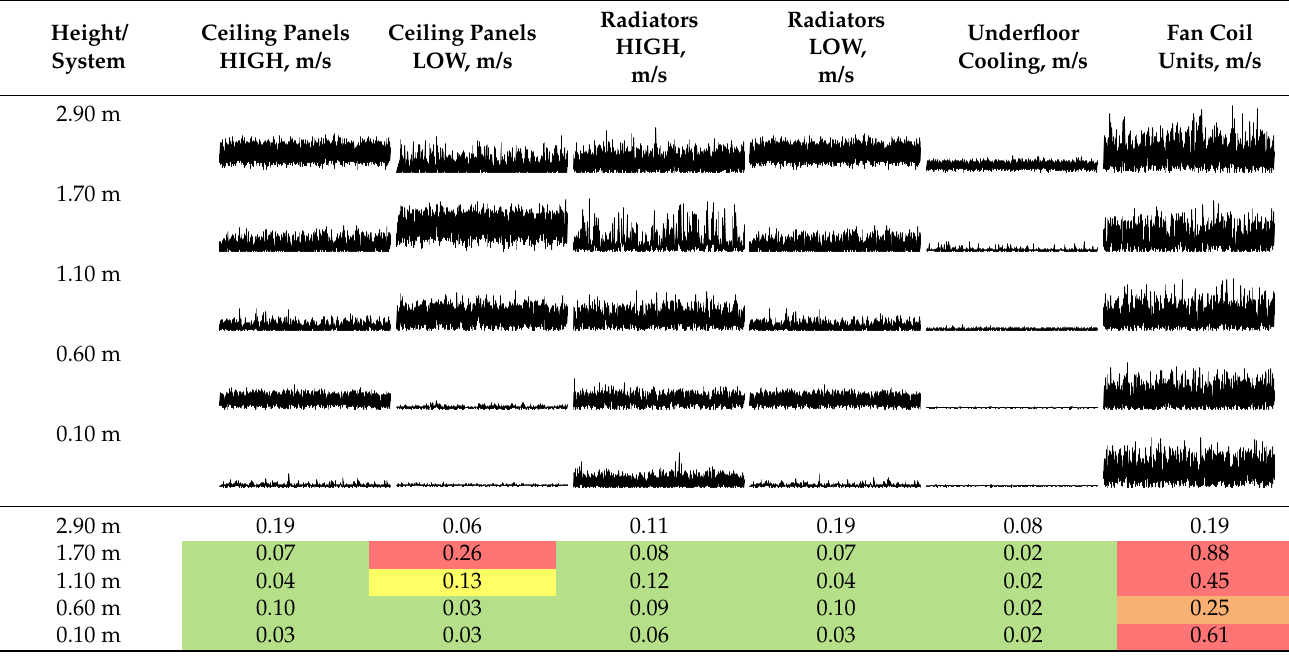
Figure 12 . Thermal image of radiator HIGH ( a ) and of ceiling panels LOW ( b ).